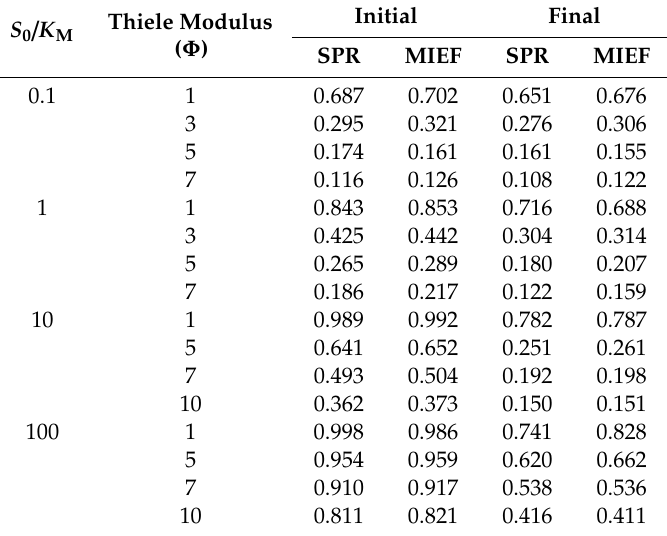
Table 5. Ratios of specific productivities (SPRs) and mean integral EF (MIEF) values at the initial and final stages of the hydrolysis of PenG by PGA at 30 ◦ C and pH 7.8.